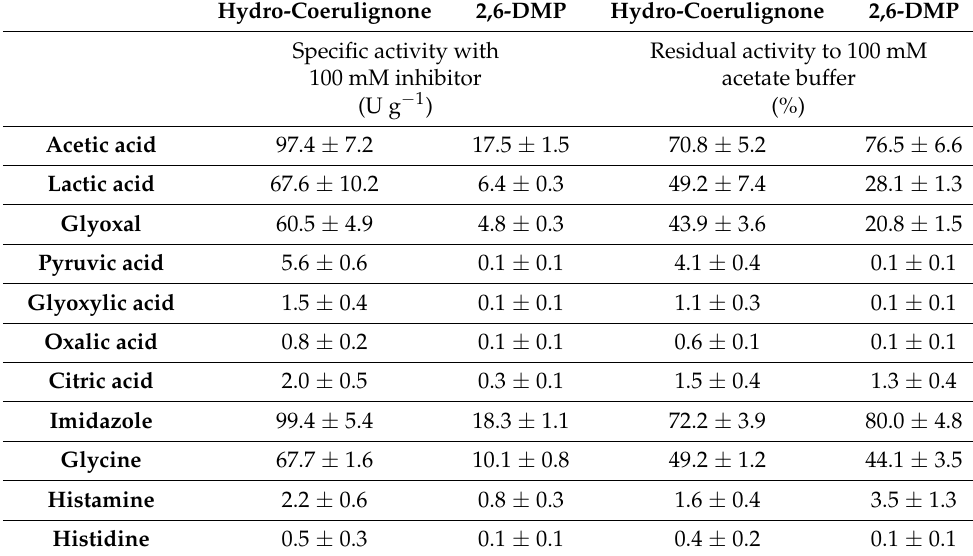
Table 2. Comparison of specific and residual activities of Nc LPMO9C.